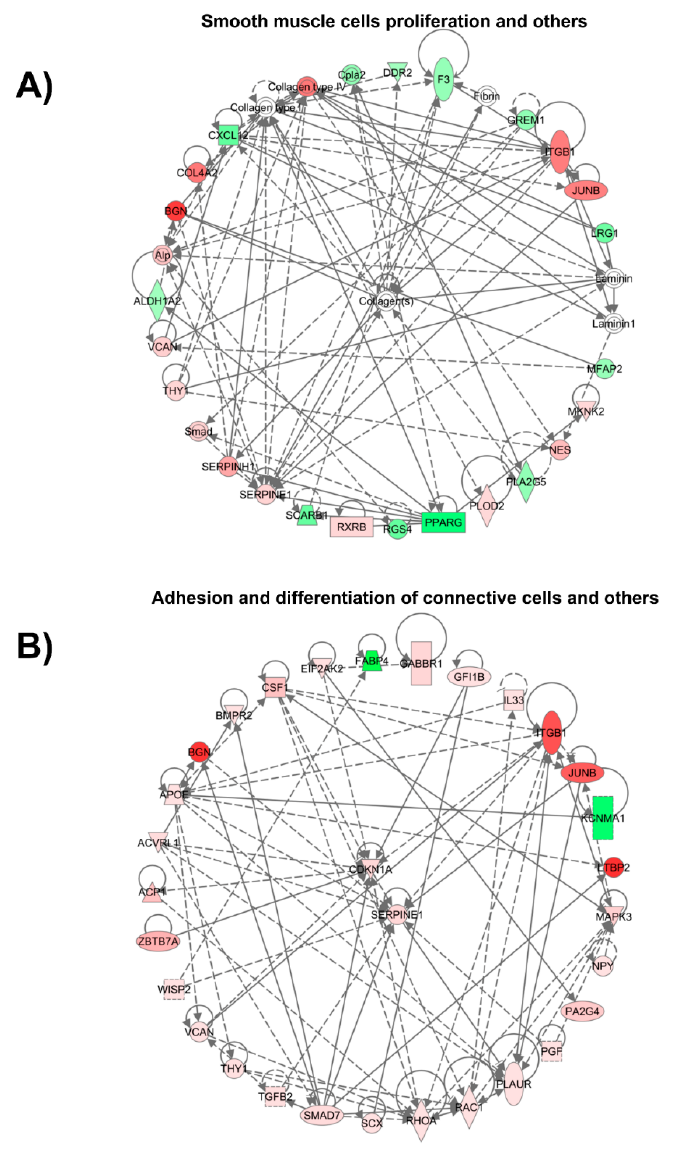
Figure 5. Selected network of genes differentially expressed. ( A ) Network of genes participating in proliferation of smooth muscle cells, cellular assembly and organization, cell function and maintenance, and tissue development at day 3 of vein arterialization remodeling; ( B ) Network of genes participating in adhesion and differentiation of connective cells and differentiation and proliferation of connective tissue at day 3 of vein arterialization remodeling.